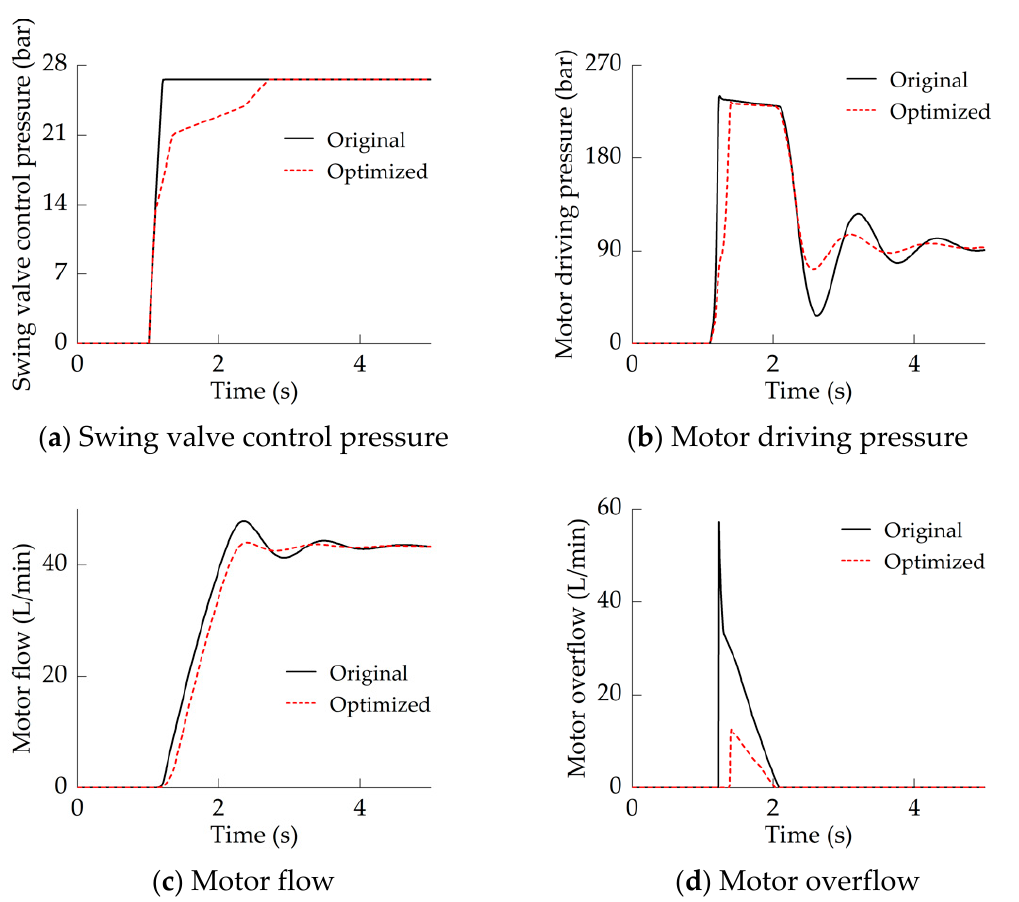
Figure 12. Swing motor acceleration characteristics (Maximum inertia).